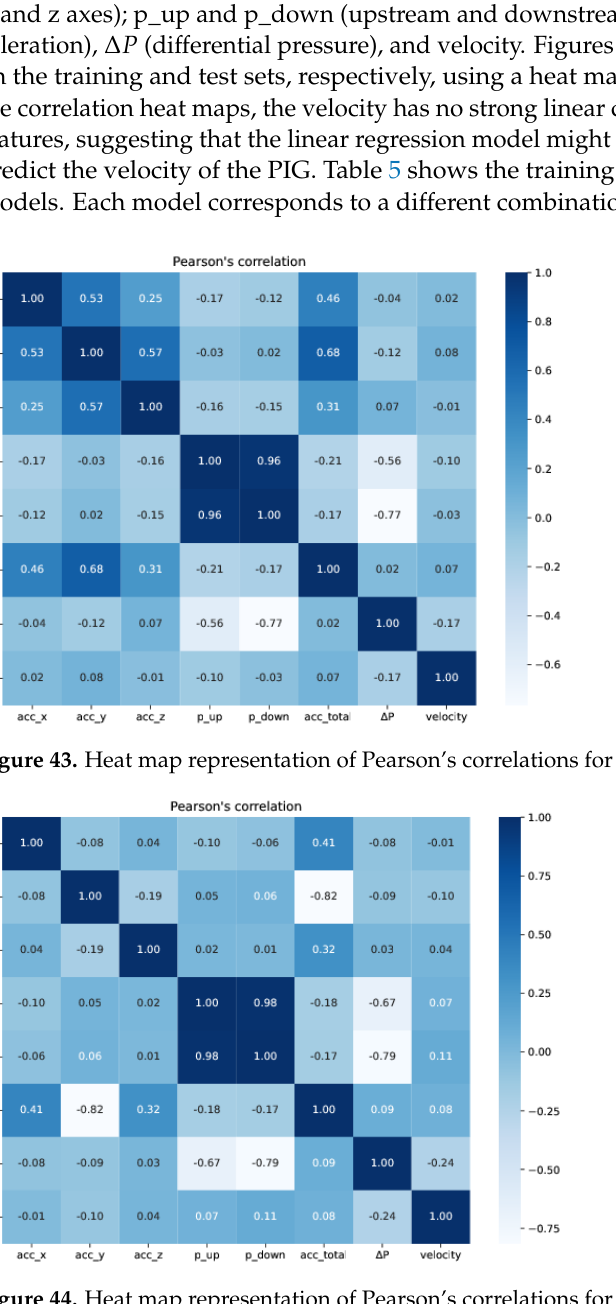
Figure 44. Heat map representation of Pearson’s correlations for the test